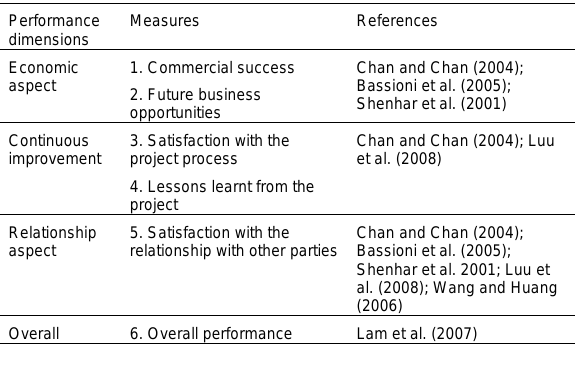
Table 2: Dimensions and measures of project performance adopted in this